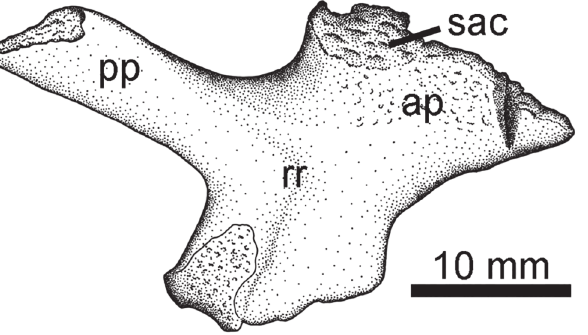
Fig 14. Pelvis Type 2. NSM014GF036.001, left ilium in medial view. Abbreviations : ap , anterior process; pp , posterior process; rr , robust ridge; sac , sacral rib